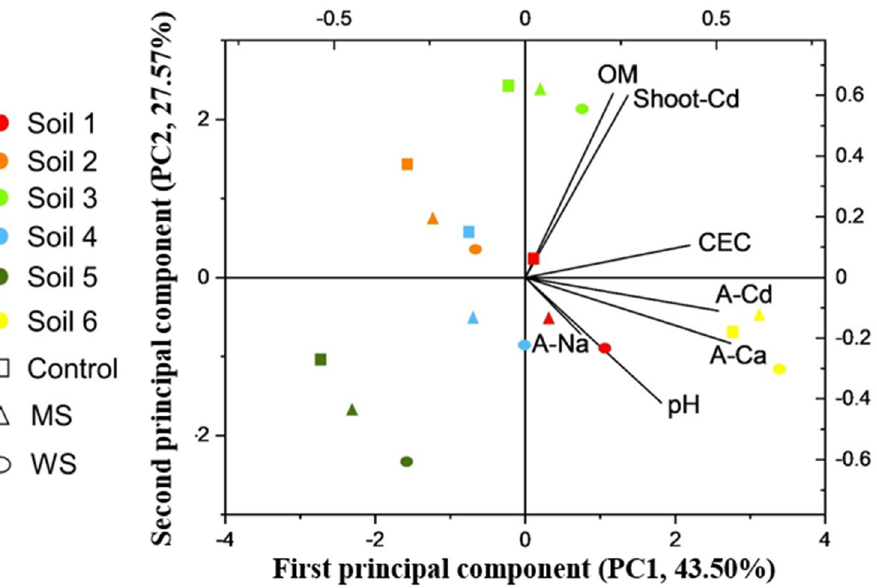
Figure 5. Principal component analysis (PCA) score plot of the selected soil properties and Cd accumulation dataset. Labeling corresponds to the treatments. OM: organic matter; Shoot-Cd: Cd concentration of amaranth shoot. CEC: cation exchange capacity; A-Cd/Ca/Na: soil available Cd/Ca/Na. MS, 4A molecular sieve; WS, wollastonite.